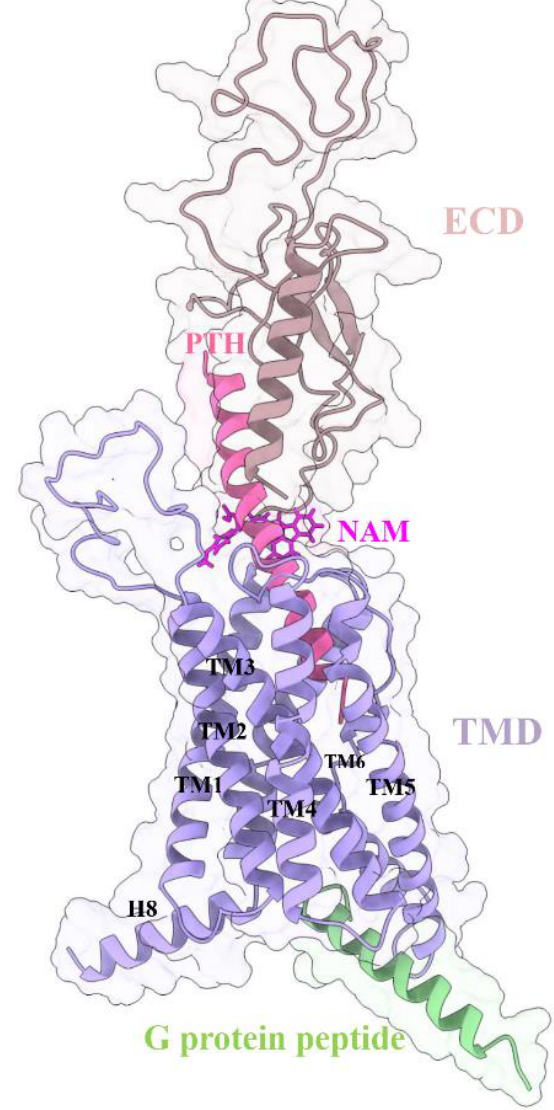
Figure 1. The system information of the modeled PTH1R complex. The protein and peptides are shown as cartoons, and the NAM molecule is shown as sticks colored in magenta. ECD, brown; TMD, purple; PTH, hotpink; G protein peptide, green.